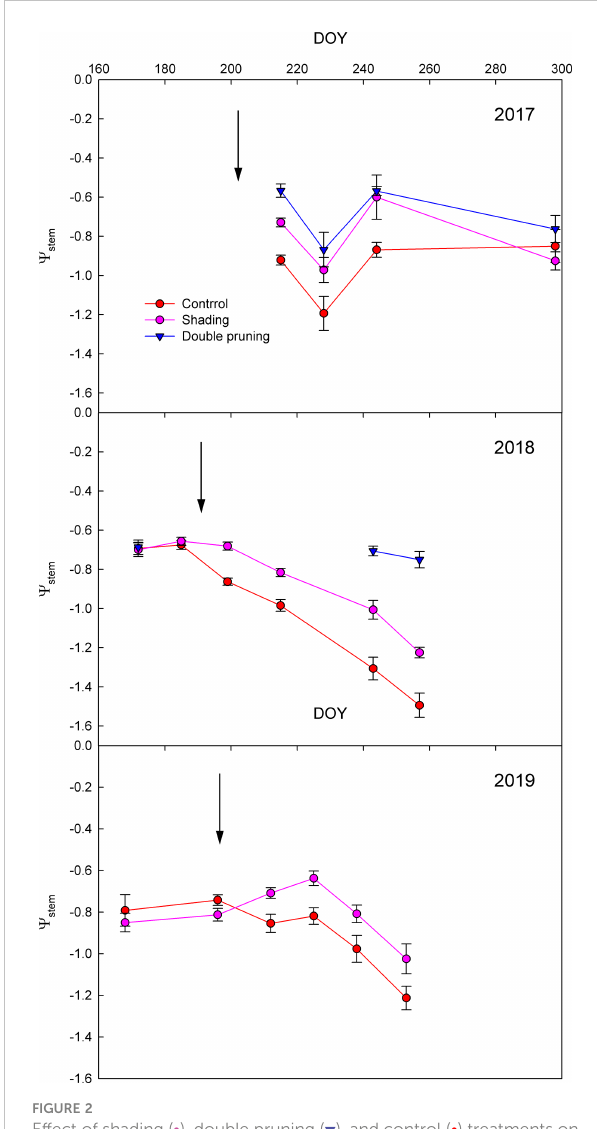
FIGURE 2 Effect of shading ( (cid:129) ), double pruning ( ▼ ), and control ( (cid:129) ) treatments on the seasonal evolution of the midday stem water potential ( Y stem ) of Macabeo grapevines in (a) 2017, (b) 2018, and (c) 2019 seasons. Data are the averages and standard errors of 16 leaves per treatment and date. The installation of nets ( ↓ ) is